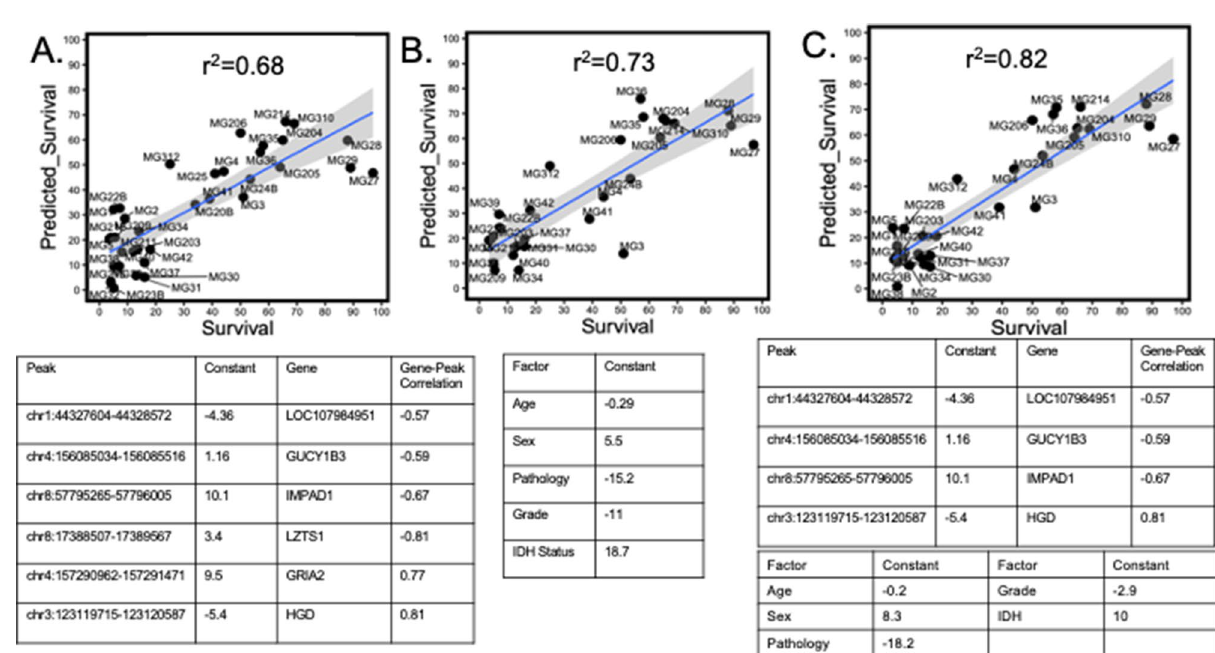
Figure 2. ( A ) The six most predictive atac-seq peaks were used to create a linear regression model to predict survival. The constants associated with this linear equation are shown in column two and the most correlated gene in column 3. ( B ) Six typically used clinical and demographic variables were used to create a linear regression model to predict survival. ( C ) Combining atac-seq peaks and clinical variables into a linear regression model yielded the most accurate prediction